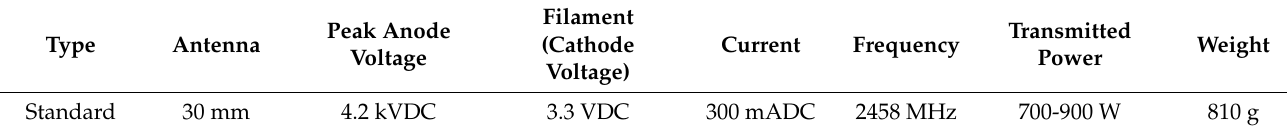
Table 1. Basic parameters of the magnetron